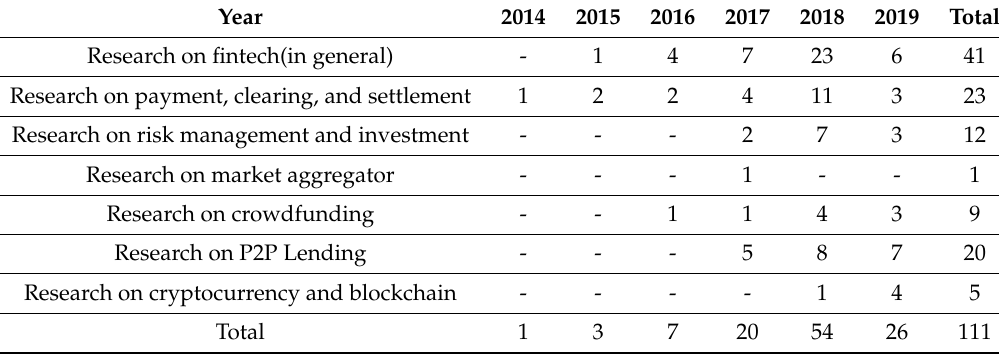
Table 1. Literature review